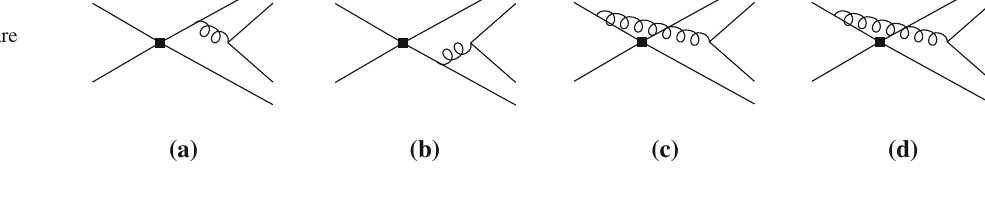
Fig. 2 The weak annihilation interactions, where a , b are factorizable diagrams, c , d are nonfactorizable